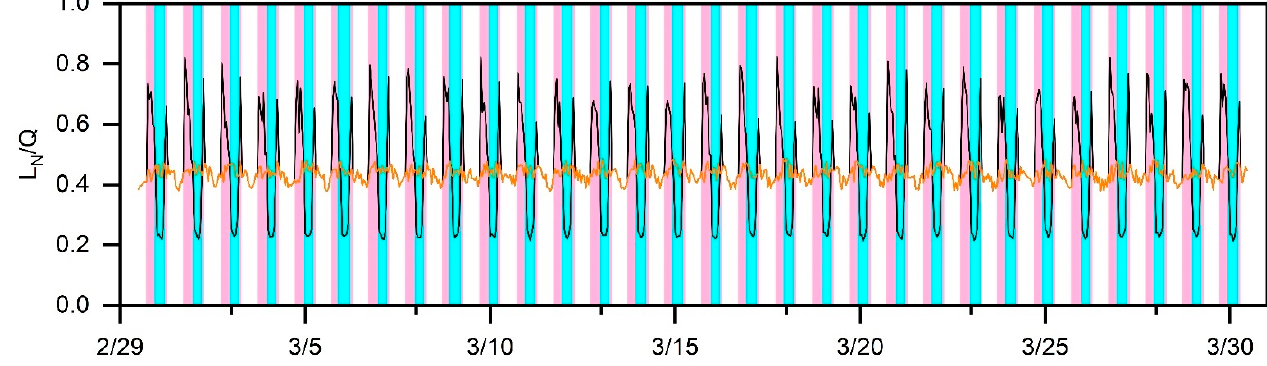
, , and the (cid:2901) Q